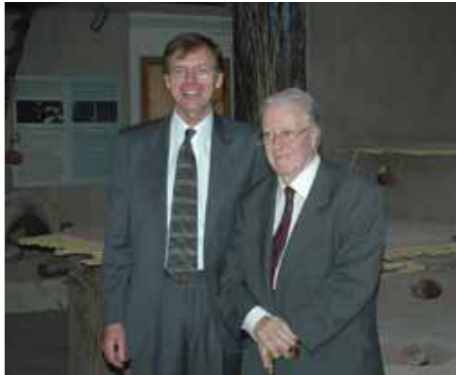
Fig. 2: The late James Mellart, with Ian Hod- der, his successor as director of the Çatalhöyük excavations (photo: Jason Quinlan).